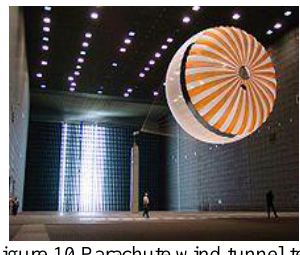
Figure 10.Parachute wind tunnel test